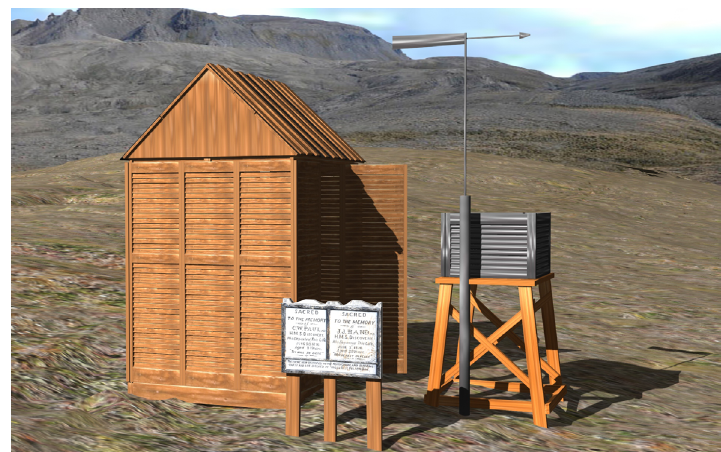
Figure 11. Computer reconstruction of an observatory at Fort Conger.